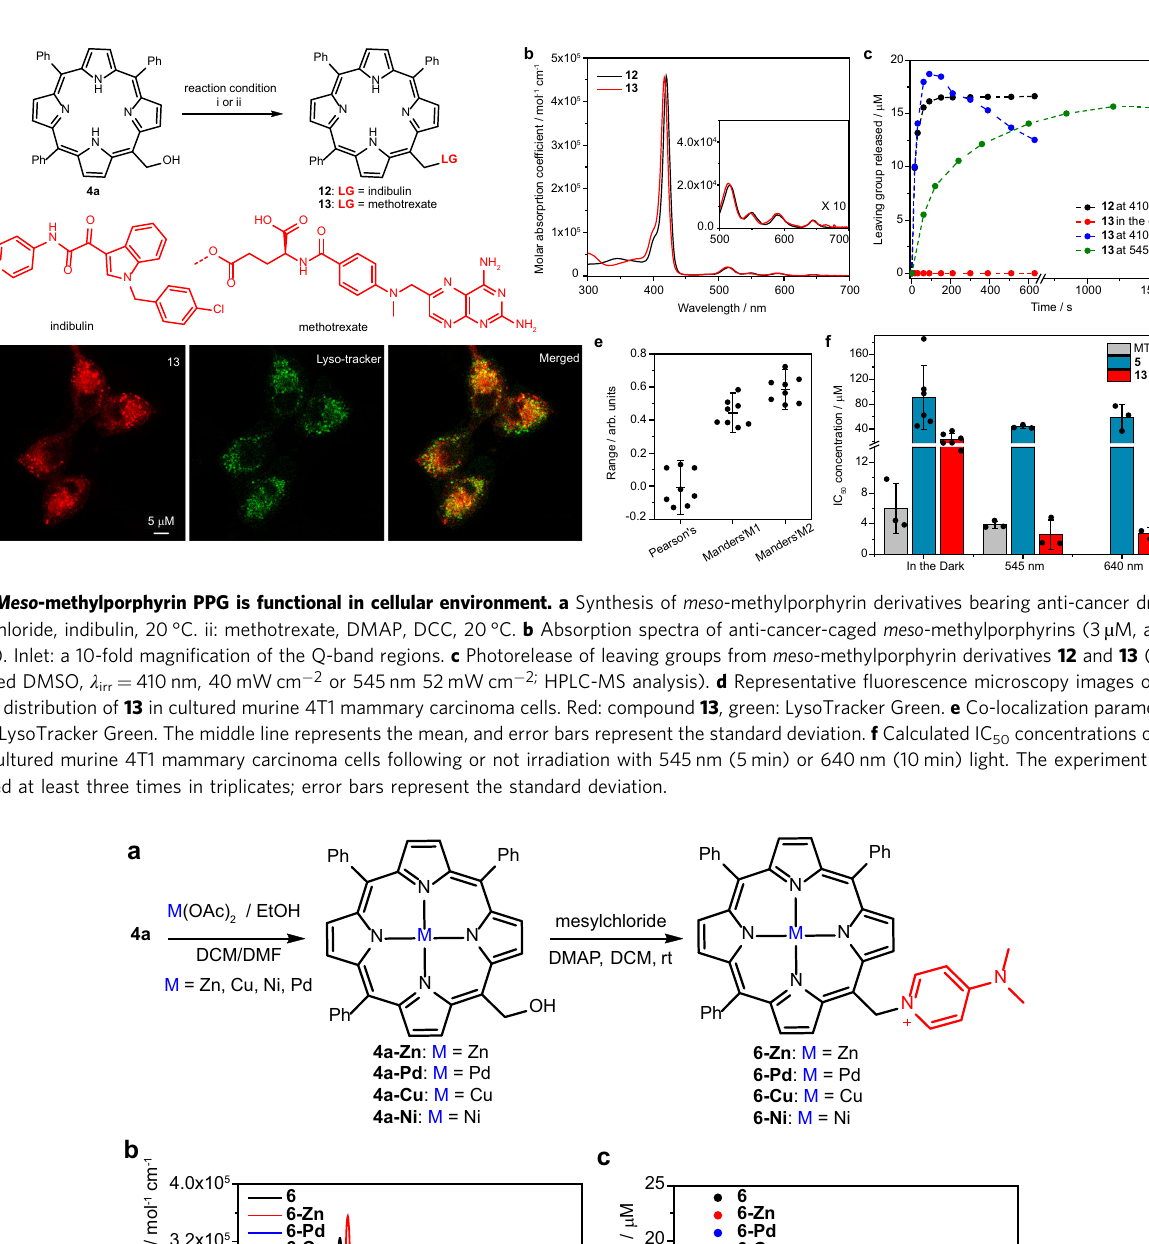
NATURE COMMUNICATIONS| (2022) 13:3614